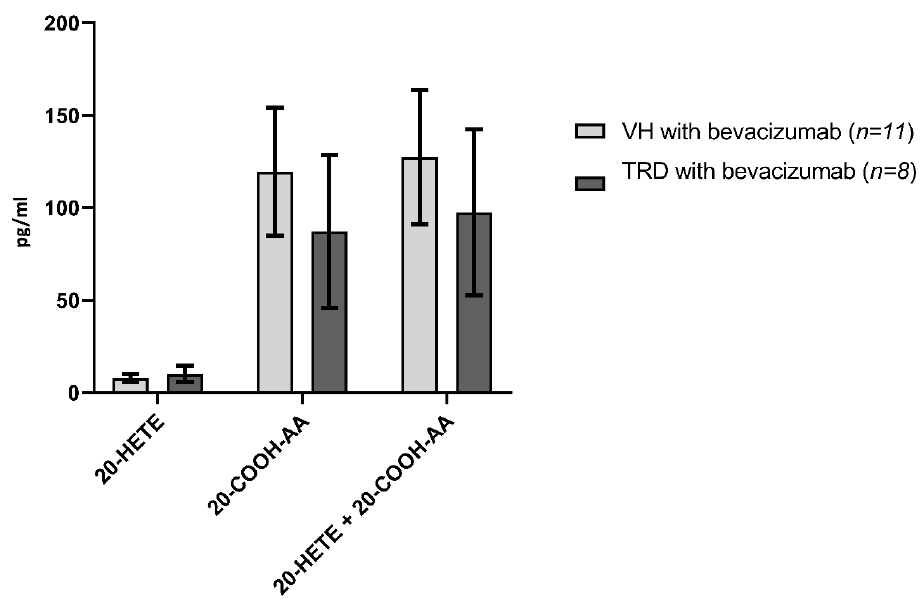
Figure 7. Human vitreous levels of eicosanoids in PDR subtypes treated with bevacizumab, VH ( n = 11) vs. TRD ( n = 8) eyes. Comparison of levels (pg/mL) of 20-HETE, 20-COOH-AA in VH vs. TRD. Table 1. Mean levels (pg/mL) +/- standard error of measurement (SEM) in human vitreous of lipoxygenase and cytochrome P450-derived eicosanoids in proliferative diabetic retinopathy (PDR, n = 31) versus controls ( n = 13).